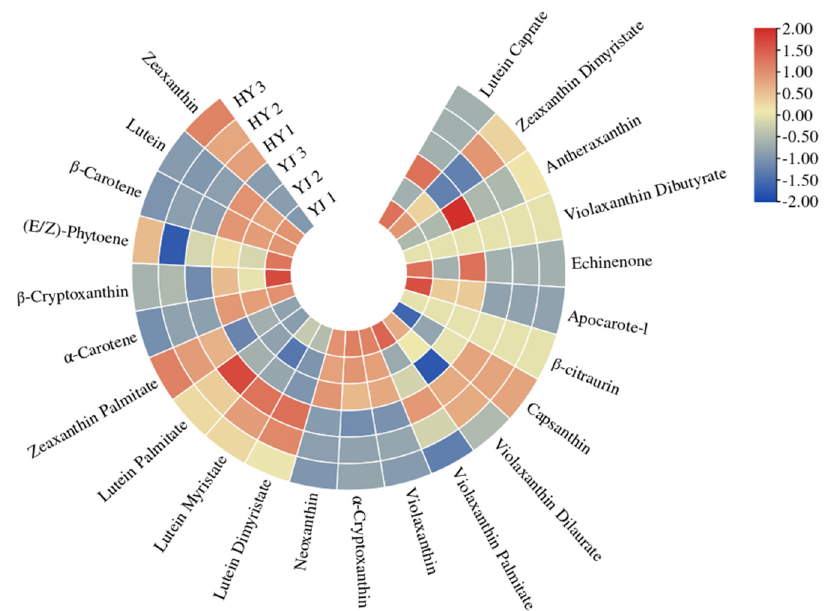
Figure 3. Heat map of carotenoids in ‘Yinghong 9’ and ‘Huangyu’. Red and blue indicate higher and lower abundances, respectively. YJ was ‘Yinghong 9’; HY was